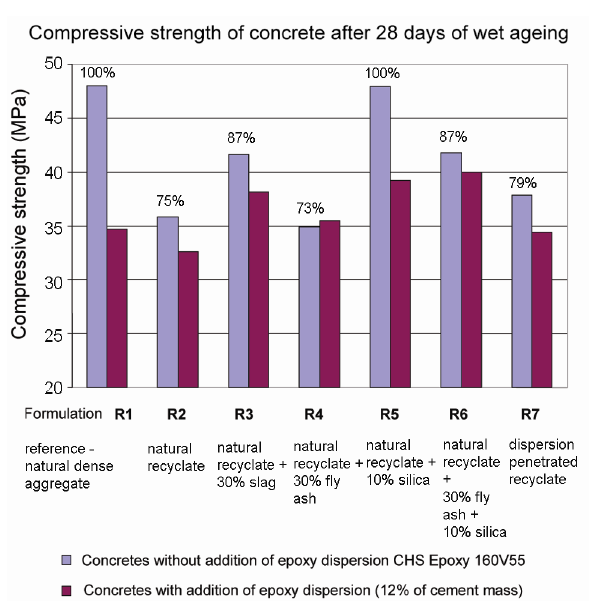
Fig. 5. Change in compressive strengths of concretes made from raw and dispersion-penetrated concrete recyclate after adding additives and